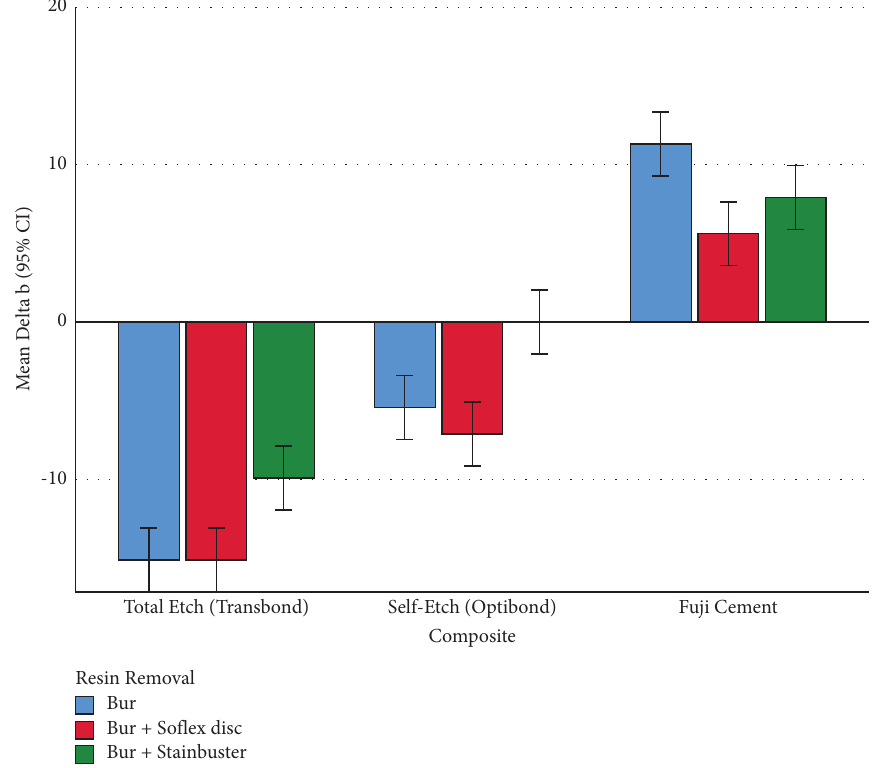
Figure 4: Means (and 95% CIs) for the Δ b parameter in all the 9 groups ( n � 9 × 10). Negative values indicate shades of blue, while positive values indicate shades of yellow.